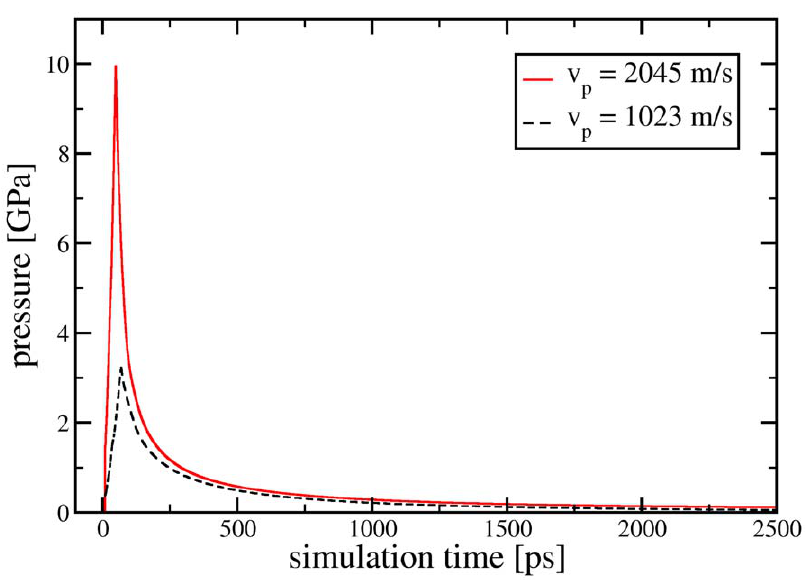
Figure 9. Pressure evolution during shock compression and subsequent release. Data for two piston velocities, v p ~ 2045 m/s and v p ~ 1023 m/s are shown, which correspond to shock-wave velocities of v s ~ 5081 m/s and v s ~ 3036 m/s.